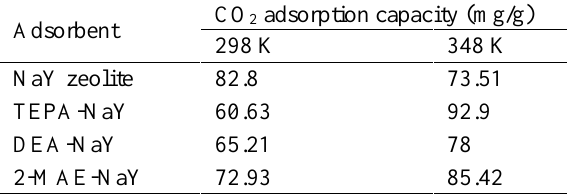
Table 4. Comparison of the CO 2 adsorption capacity of the amine modification zeolites with other porous materials. CO 2 adsorption Adsorbent Condition Reference capacity (mg/g) Zeolite